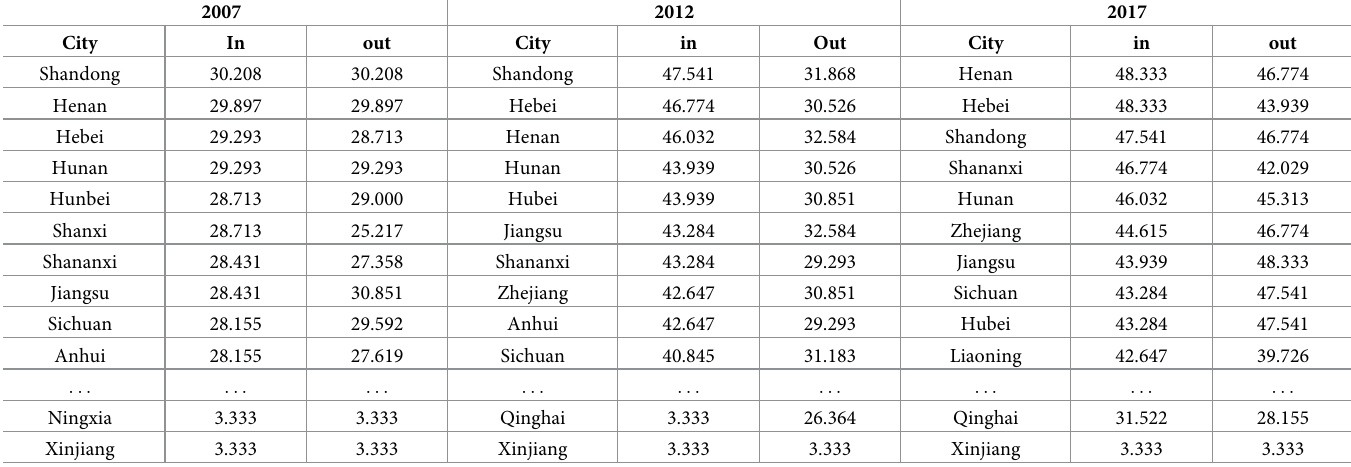
Table 4. Closeness